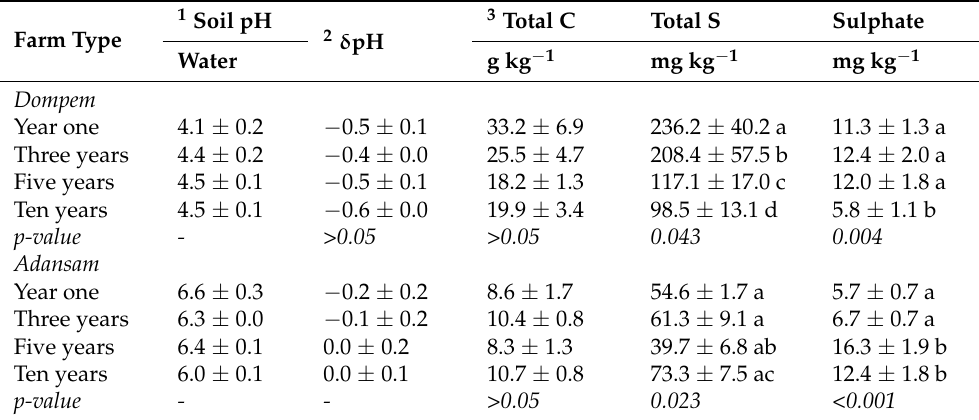
Figure 2. Spearman between reconnaissance survey total S and SOC. Table 3. Soil and δ pH, total C, N, S and sulphate contents of soils from different farms in Dompem ( n = 9 ± One standard error of means) and Adansam ( n = 5 ± One standard error of